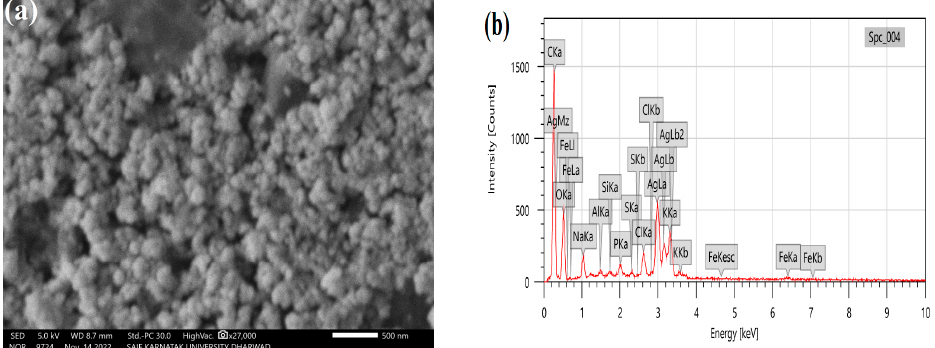
Figure 6. ( a ) SEM micrograph and ( b ) EDS spectrum of biosynthesized LnFb-AgNPs from L. nepetifolia flower bud extract.